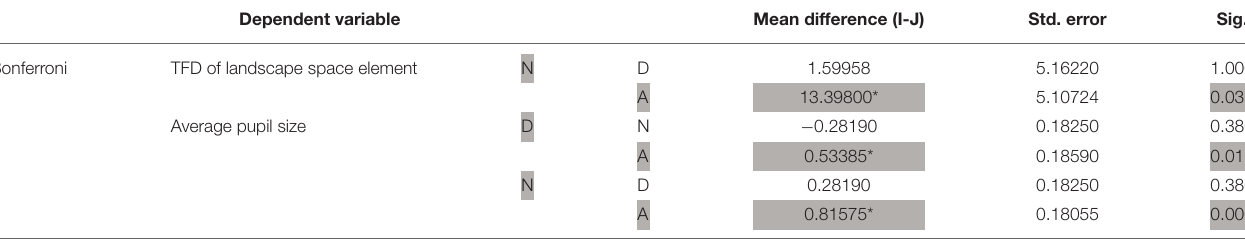
TABLE 5 | The Bonferroni correction for multiple comparisons for the difference of EMM between occupation.